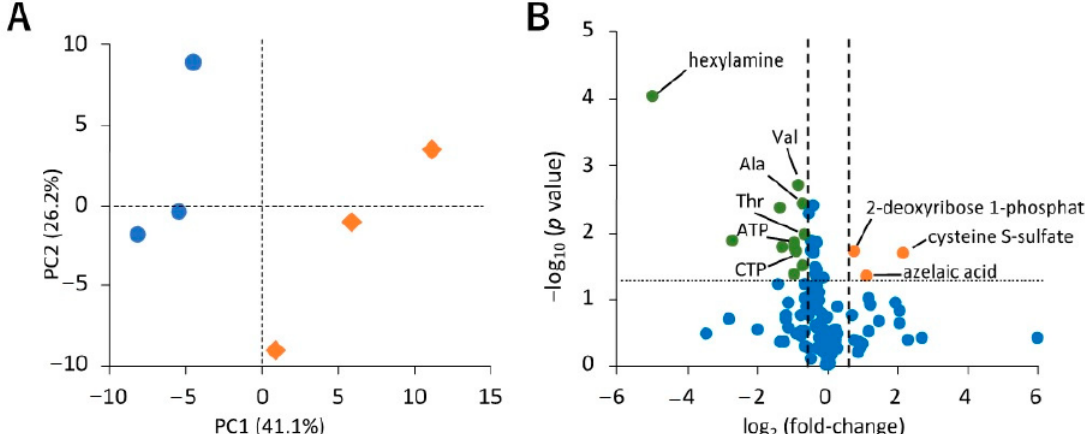
Figure 3. Effect of hypoxic stress on hydrophilic metabolite profiles in small extracellular vesicles (sEVs). ( A ) Principal component analysis (PCA) score plots for normoxia (blue circle) and hypoxia (orange diamond) samples based on hy- drophilic metabolome data. The contribution ratios were 41.1% and 26.2% for PC1 and PC2, respectively. ( B ) Volcano plot showing the differential accumulation of metabolites under normoxia and hypoxia. The Student’s t -test was used to determine the p value. The plots marked in orange and green are for metabolites that were increased and decreased under hypoxia, respectively. Metabolites that were detected in over 50% samples were included for the analysis. Data were normalized by the number of particles, as quantified by NanoSight. As hexylamine was detected only under normoxia, its log 2 (fold-change) value is displayed as − 5, n =